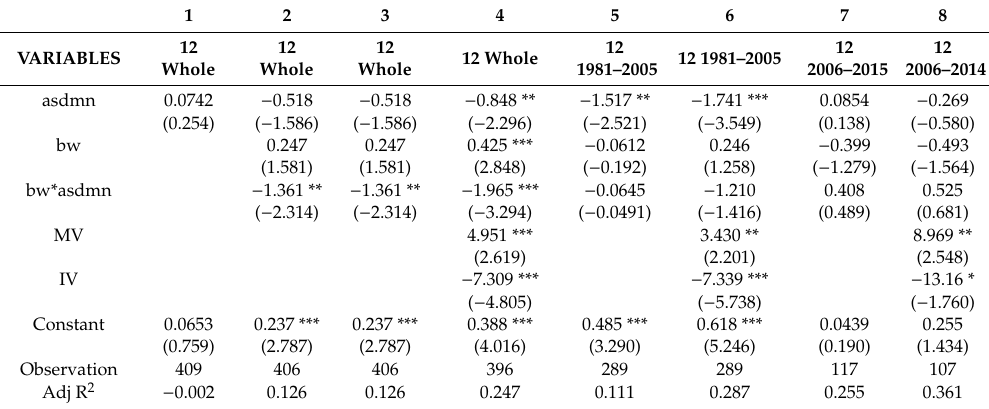
Table 10. Returns on an alternative dispersion measure and continuous sentiment values. 1